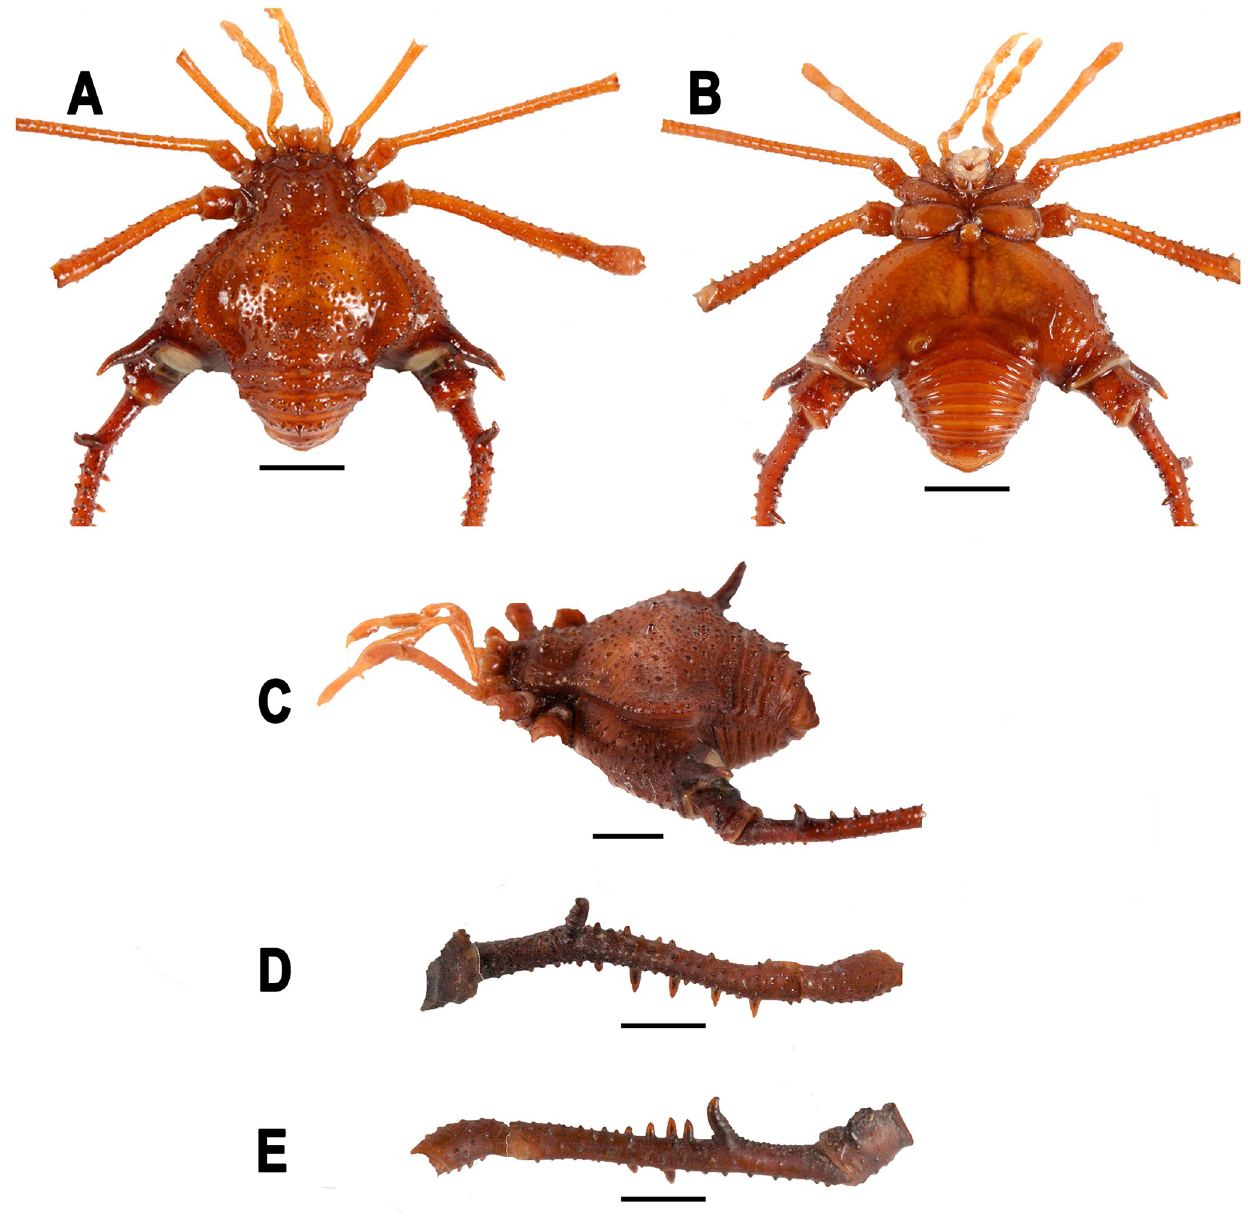
Fig 6. Neosadocus robustus ( Ilhania robusta male lectotype, MNRJ 42289). A. Dorsal view. B. Ventral view. C. Left lateral view. D–E. Right trochanter– patella IV (D: retrolateral view; E: prolateral view). Scale bars: 3 mm.